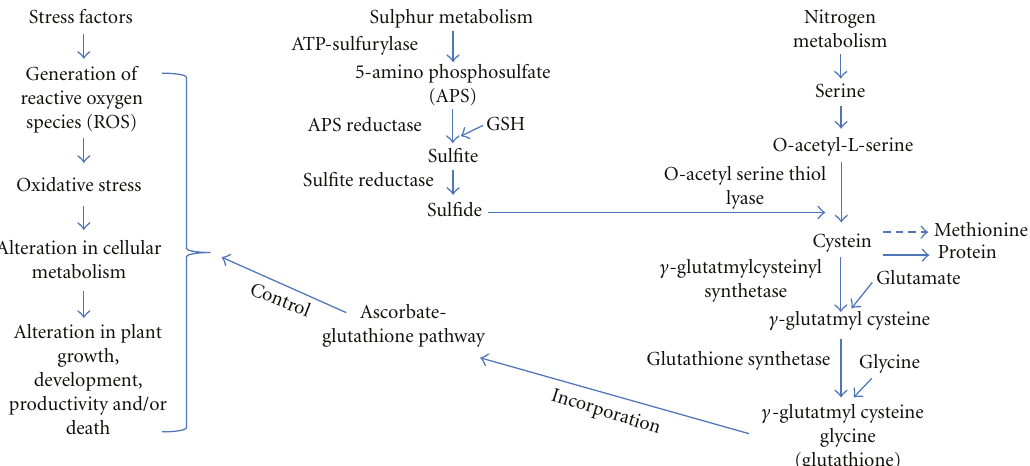
Figure 1: A schematic presentation of major events in sulfur (S) and nitrogen (N) nutrition-mediated control of glutathione (GSH) biosynthesis and its subsequent incorporation into ascorbate-glutathione (AsA-GSH) pathway for the regulation of cellular metabolism, plant growth, development, and productivity via removal and/or metabolism of stress-induced/generated reactive oxygen species (ROS) in plants. See text for